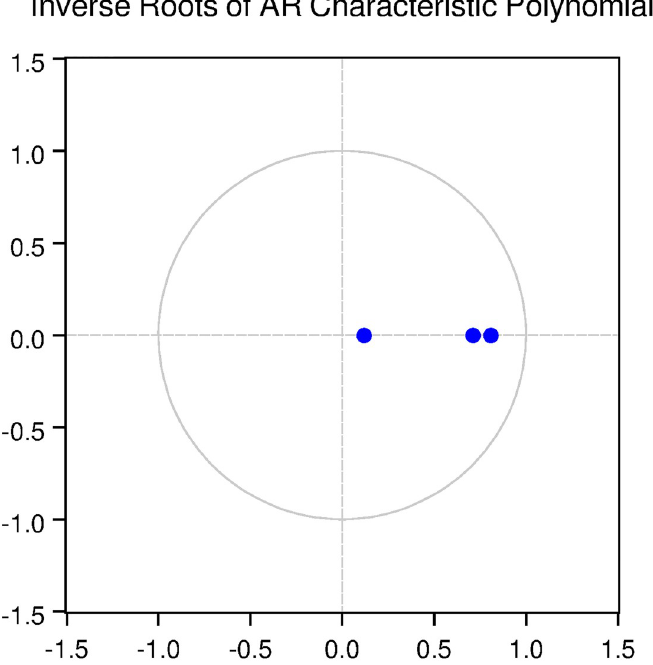
Fig 6. Inverse roots of AR characteristic polynomial for Japanese data when P = 1 (proposed model).